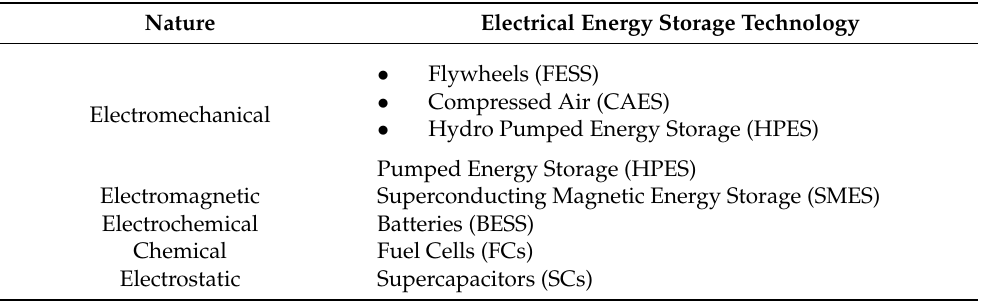
Figure 1. Storage time against the power delivered for electrical energy storage technologies, adapted from [5]. Table 1. ESSs Classification according to their nature, data from [2].